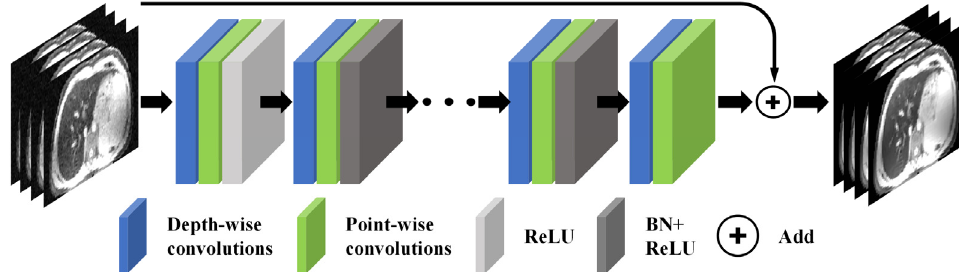
Figure 2. The architecture of denoising network.